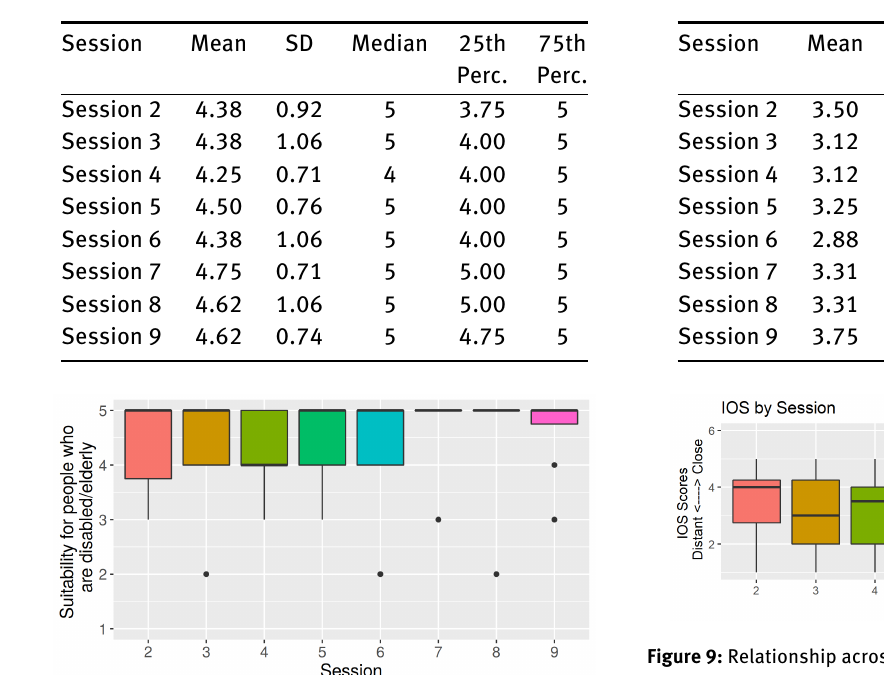
Table 5: Robot for Others.